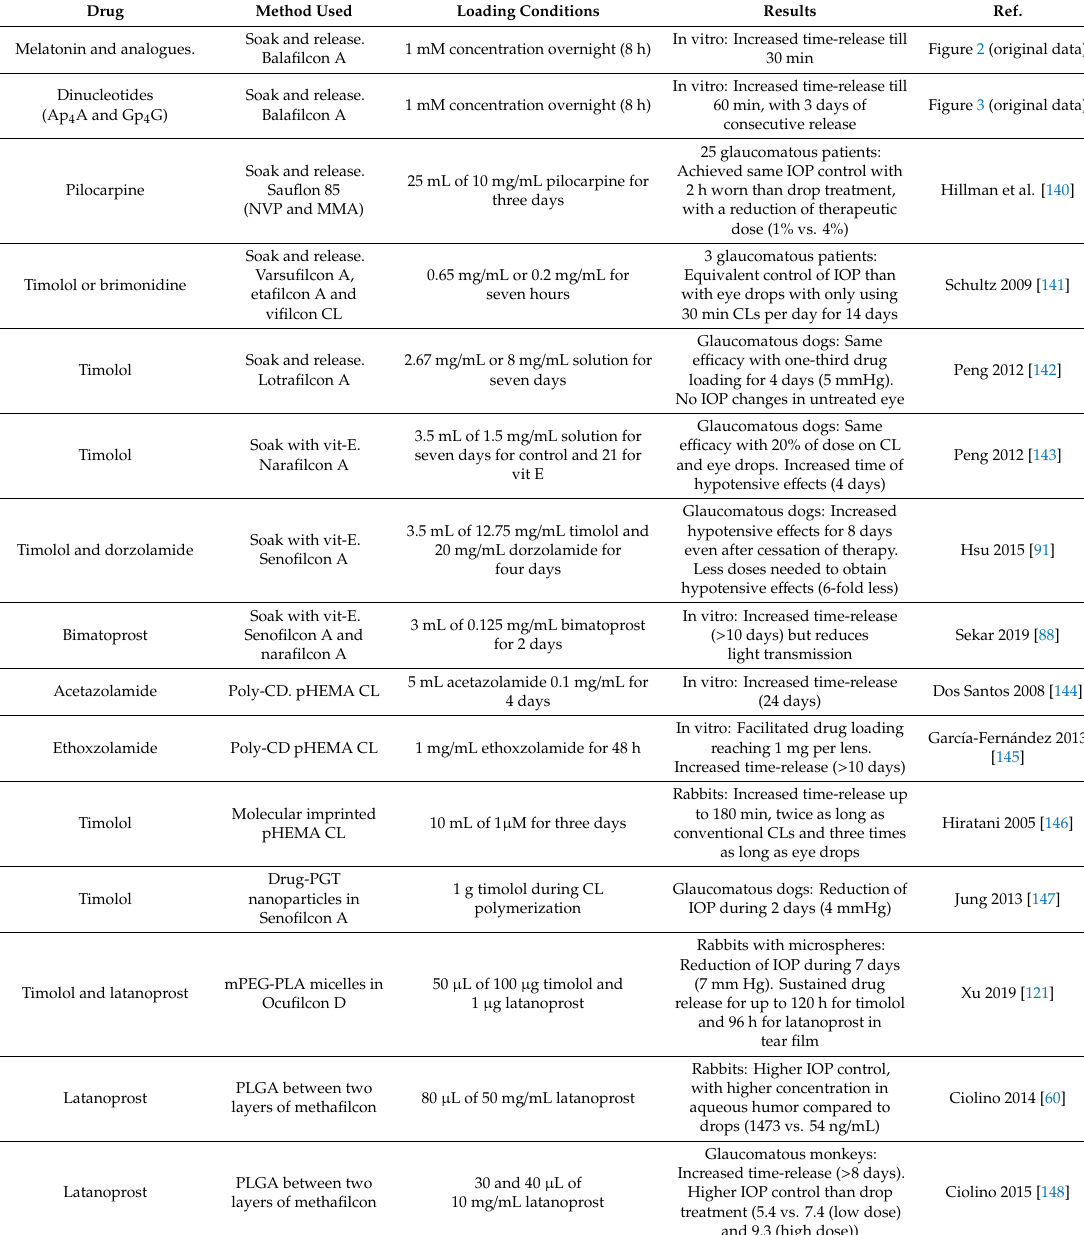
Table 3. Drug used with CLs as drug delivery systems for glaucoma. Drug Method Used Loading Conditions Results Ref. Melatonin and